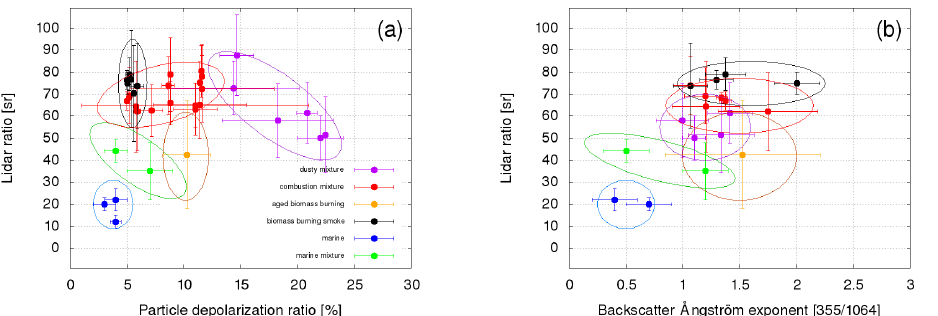
Figure 15. ( a ) Aerosol classification for 33 investigated cases based on the LR and PDR at 355nm in a number of different weather conditions and with different predominant aerosols (marine, marine mixed with local, local combustion, local biomass burning, local aged biomass burning, mineral dust mixed with local); ( b ) distributions of BAE between 355 and 1064nm and LR at 355nm in the same constituent of aerosol corresponding with ( a